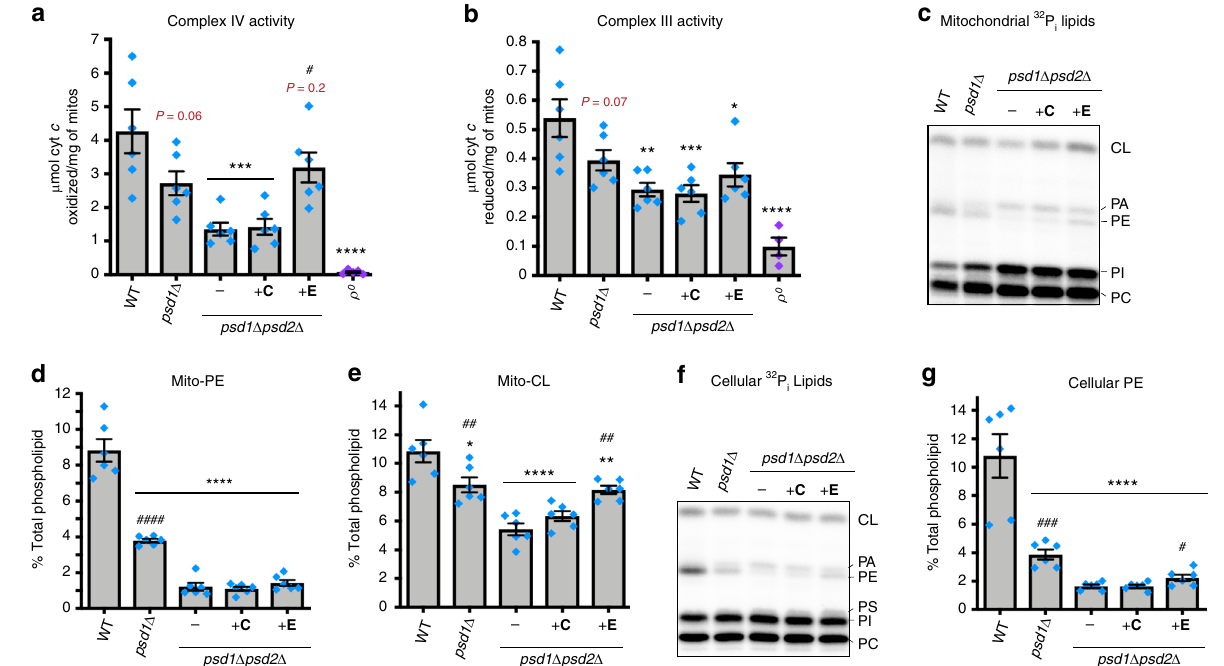
Fig. 7 Ethanolamine rescues the activity of complex IV but not complex III. The indicated yeast strains were grown in rich lactate without (WT, psd1 Δ , and psd1 Δ psd2 Δ ) or with choline ( + C) or ethanolamine ( + E). a Complex IV activity and ( b ) complex III activity in isolated mitochondria solubilized in 0.5% (w/v) DDM (mean ± S.E.M. for n = 6 biologically independent experiments, except for ρ 0 , n = 4). Statistical comparisons (ns, P > 0.05; 1 symbol P ≤ 0.05; 2 symbols P ≤ 0.01; 3 symbols P ≤ 0.001; 4 symbols P ≤ 0.0001) vs. WT (asterisk) or psd1 Δ psd2 Δ (number sign) were performed by one-way ANOVA with Tukey ’ s multiple comparison test. P values for decreases that did not achieve signi fi cance are reported in red and were analyzed by student t test versus WT. c – e Mitochondrial phospholipids from the indicated strains were labeled overnight with 32 P i and separated by TLC. c Representative TLC plate for mitochondrial 32 P i lipids. Quantitation of mitochondrial ( d ) PE and ( e ) CL levels (mean ± S.E.M. for n = 6 biological replicates). Signi fi cant differences compared to WT (asterisk) or psd1 Δ psd2 Δ (number sign) were calculated by one-way ANOVA with Holm – Sidak pairwise comparisons. f Representative TLC plate for cellular 32 P i lipids. g Quantitation of cellular PE levels (mean ± S.E.M. for n = 6 biological replicates). Signi fi cant differences compared